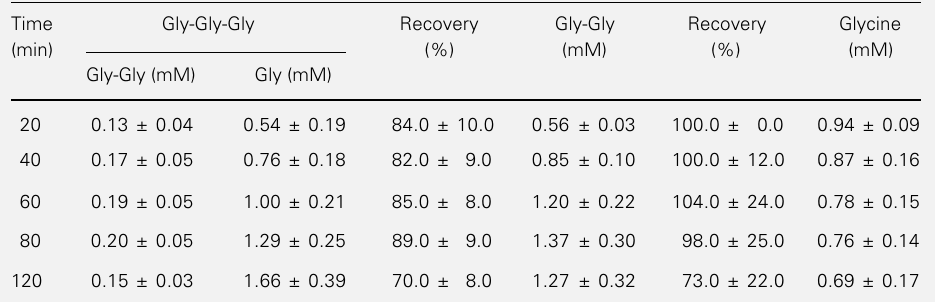
Table 1 - Diglycine and glycine accumulation during renal perfusion with Krebs-Henseleit solution in the presence of 1 mM triglycine (Gly-Gly-Gly) or diglycine (Gly-Gly) and recovery of the fragments. Conditions of the experiments as described in Figure 1. Results are reported as means – SEM; 8 experiments for triglycine and 3 experiments for diglycine and glycine; recovery of triglycine = (Gly-Gly-Gly) + (Gly-Gly) + (Gly)/3, expressed in %; recovery of diglycine = (Gly-Gly) + (Gly)/2, expressed in